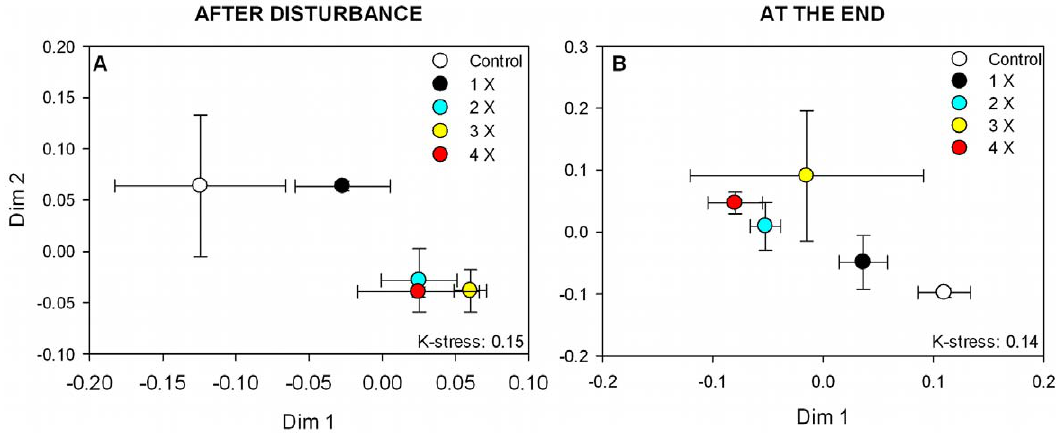
Figure 2. NMDS plots showing the changes in BCC in relation to disturbance frequency (Experiment 2). NMDS are based on Bray-Curtis distances according to bacterial community composition patterns (t-RFLP), after the disturbance (A) and at the end of the experiment (B). Error bars indicate standard errors.